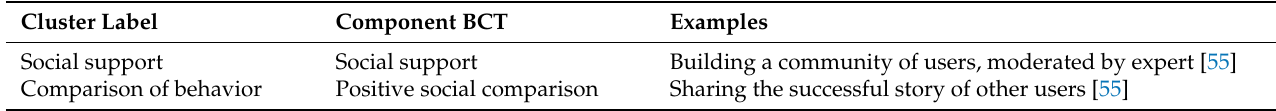
Table 7. BCTs focusing on social support (Category-III